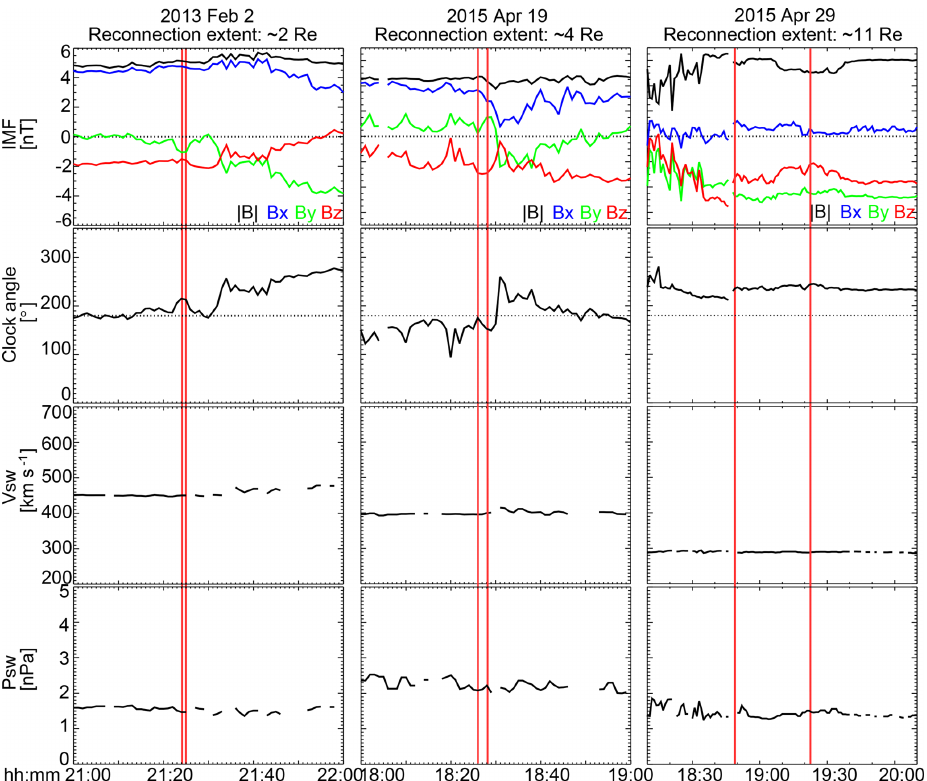
Figure 8. Comparison of the IMF and solar wind driving conditions between the reconnection events on 2 February 2013, 19 April 2015, and 29 April 2015. From top to bottom: IMF in GSM coordinates, IMF clock angle, solar wind speed, and solar wind dynamic pressure. The red vertical lines mark the times of the satellite–ground